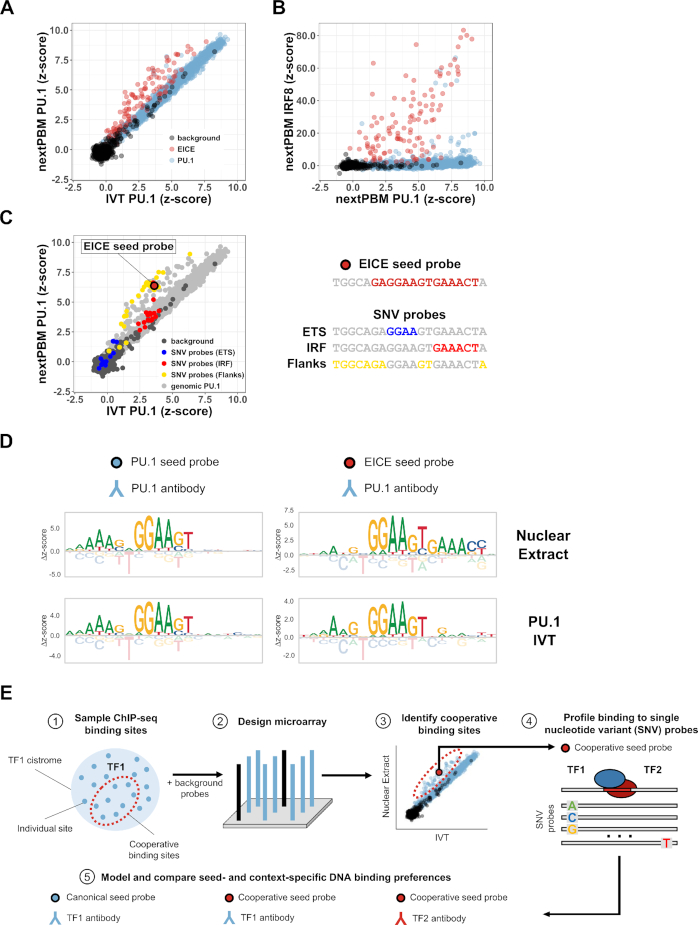
DNA sequence determinants of PU.1-IRF8 cooperative binding. (A) Scatterplot of PU.1 binding z-scores obtained from nuclear extract (nextPBM) versus in vitro transcribed/translated (IVT) PU.1 for random background probes (n = 500), ETS-IRF composite element (EICE) probes (n = 116), and canonical PU.1 probes (n = 2499). (B) Scatterplot of IRF8 binding z-scores in nuclear extract versus PU.1 binding z-scores in nuclear extract for the same sets of probes as in (A). (C) Left – scatterplot of PU.1 binding z-scores in nuclear extract versus IVT PU.1 for probes included in (A) and SNV probes corresponding to the EICE seed probe shown right. Highlighted probes correspond to SNV probes containing variations in either the ETS core half-site (blue), IRF core site (red), or flanking and linker bases (yellow). Right - schematic of EICE seed probe and bases comprising individual sub-elements. (D) Sequence logos obtained using a canonical PU.1 seed probe (left column) and a cooperative ETS-IRF composite element (EICE) probe (right column) from nuclear extract (top row) and from IVT PU.1 (bottom row). (E) Workflow schematic for identifying cooperative binding sites using nextPBM. 1 – ChIP-seq sites for a given transcription factor of interest (TF1) can be sampled and used to construct probes for a microarray design. The sample will contain sites where TF1 is cooperatively bound with other factors. 2 – TF1 sample probes are combined with a set of random background probes against which binding z-scores are computed to form the basis of a microarray design. 3 – Profiling binding of TF1 in nuclear extract versus IVT allows for the discovery of cooperative binding sites bound higher in nuclear extract (shown above the diagonal). 4 – Cooperative sites identified can be used as seed probes in a subsequent experiment where SNV probes are included in the microarray and profiled. 5 – Binding to SNV probes is used to model and compare seed- and context-specific DNA binding preferences of TF1 to identify composite elements and likely binding partners.